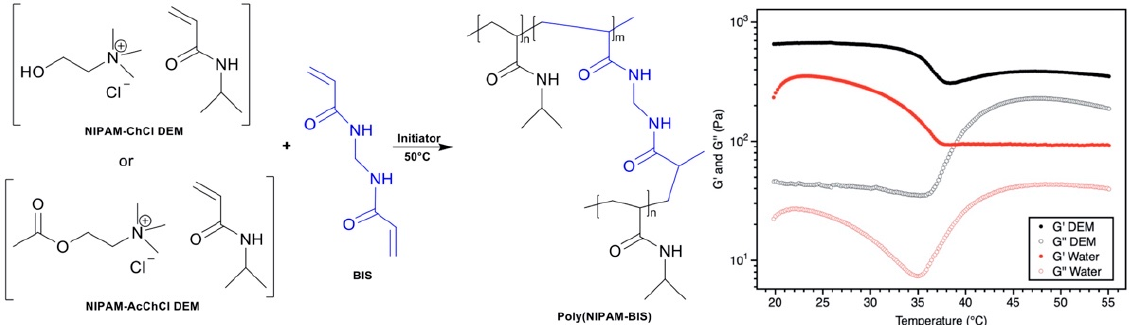
Figure 7. Thermoresponsive hydrogels via 3:1 N -isopropylacrylamide (NIPAM):ChCl/AcChCl polymerizable eutectics. The resulting hydrogels exhibited a significant increase in shear modulus compared to equivalent gels prepared in water. Adapted from Ref [104] with permission from The Royal Society of Chemistry, copyright 2020.